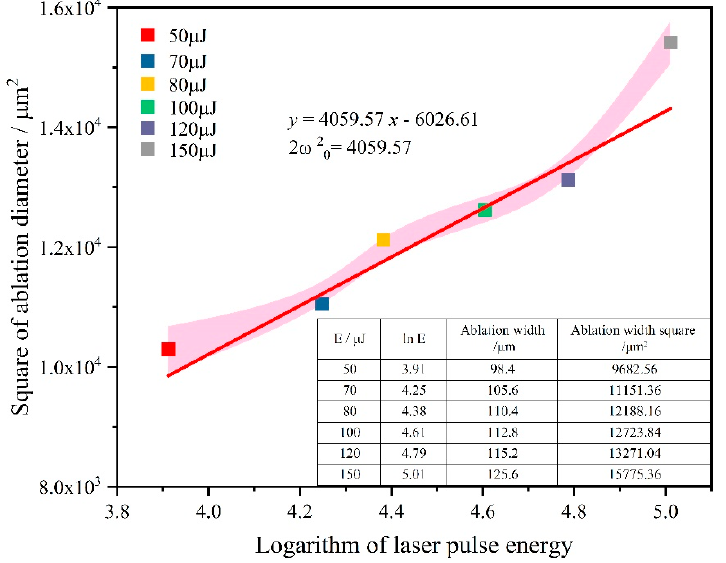
Figure 15. Scatter plot of the square of ablation width against the logarithm of laser power. The red line is the linear fitting of the plot, the fitting function is shown in the upper left.